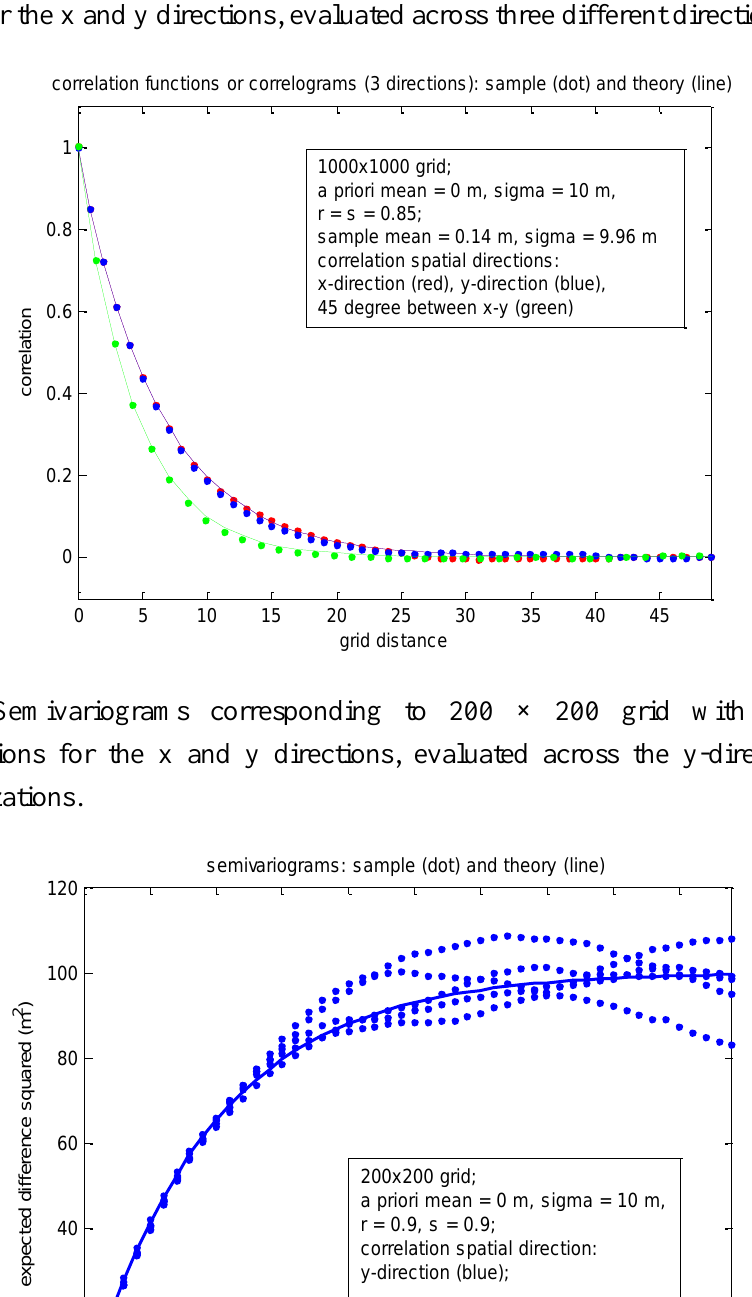
Figure 9. Sample statistics corresponding to 1000 × 1000 grid with the same a priori correlations for the x and y directions, evaluated across three different directions.